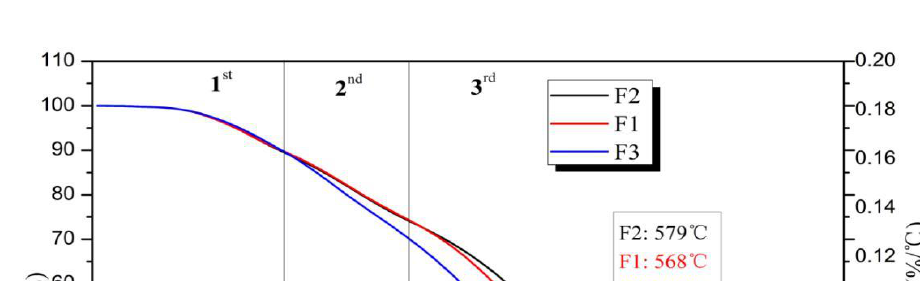
Table 2. Combustibility characteristic parameters of furanic-glyoxal foams.